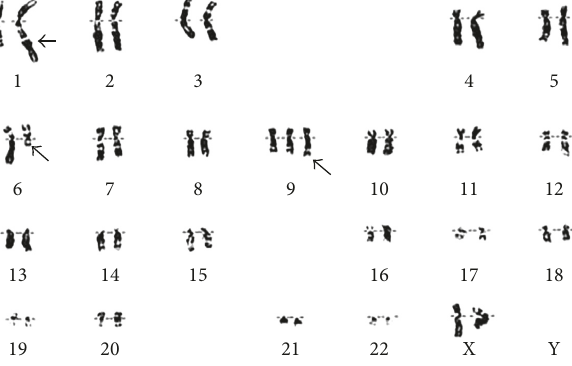
Figure 2: Karyotype showing trisomy 9, t (1;